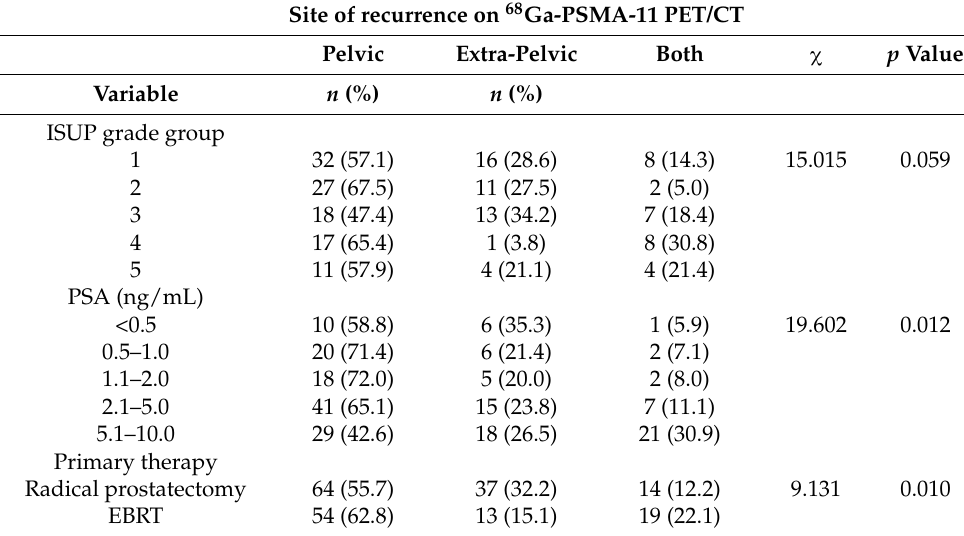
Table 3. Site of recurrence stratified according to ISUP grade group, PSA level, and prior primary therapy.